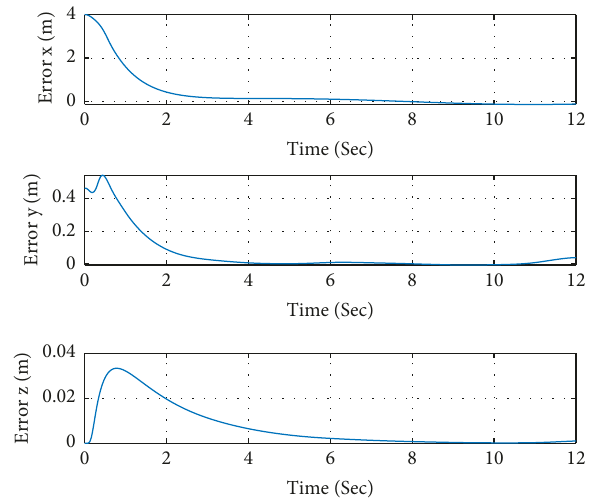
Figure 11: The curve of trajectory tracking error.